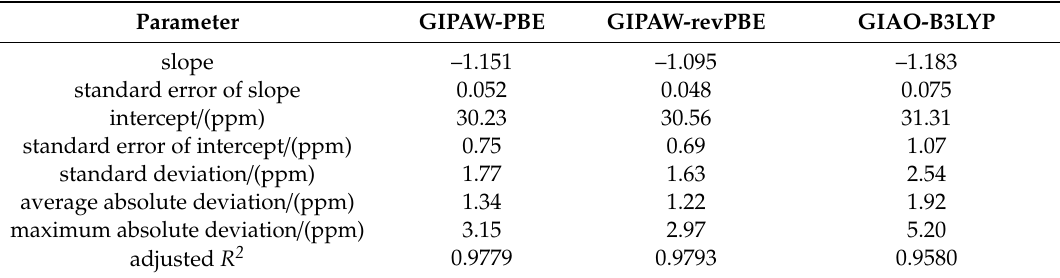
Table 4. Statistical evaluation of the agreement between predicted eigenvalues of the 1 H chemical shielding tensors and experimentally established eigenvalues of the 1 H chemical shift tensors of the four proton sites in citric acid (12 data